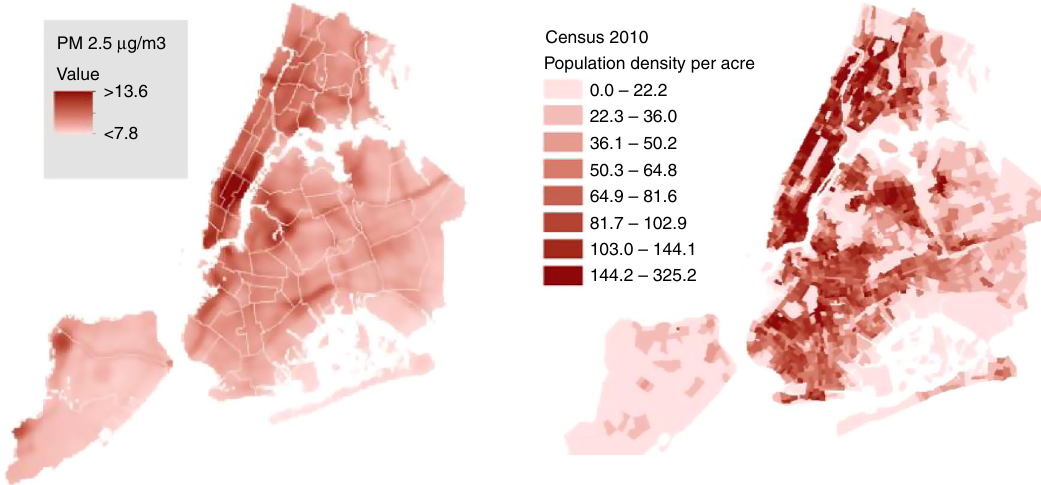
Fig. 2 (Left) Yearly average distribution of particulate matter PM 2.5 . Source: New York City Community Air Survey (NYCCAS). (Right) NYC-population density (source American Community Survey, open